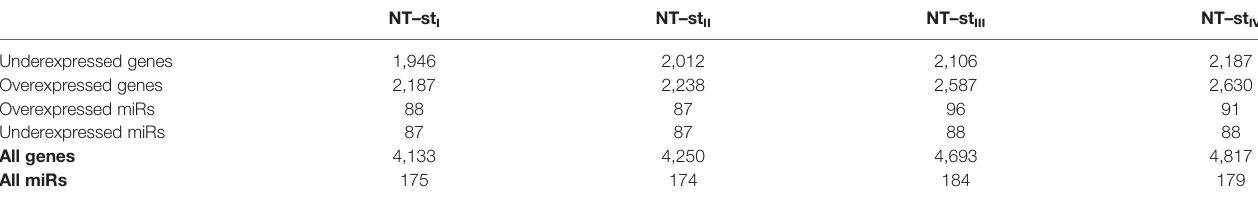
TABLE 3 | DEGs and DEMs for each progression stage as compared with non-tumor adjacent tissue-derived samples.